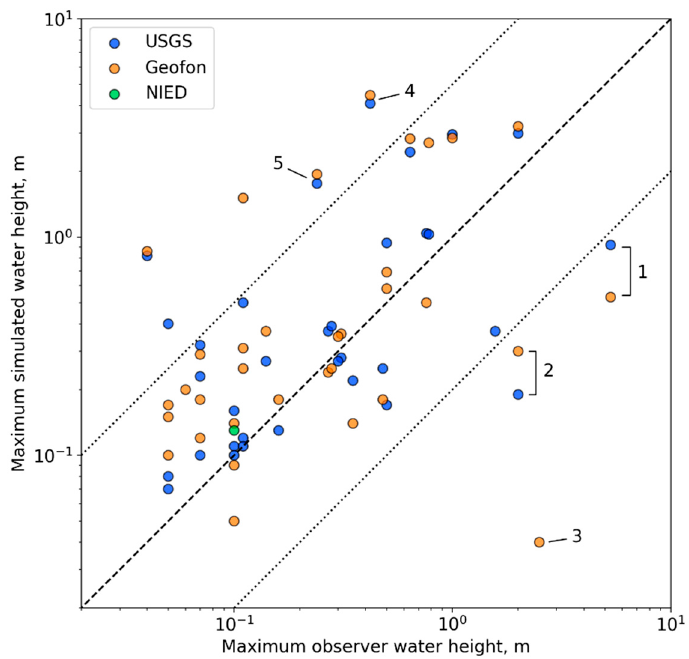
Figure 6. Comparison of the maximum tsunami runups from the GHTD data and the maximum tsunami amplitudes from the hydrodynamic simulations.